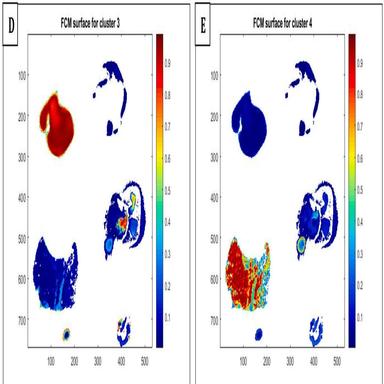
Fuzzy C-Means (FCM) clustering analysis of the NMI region at ambient temperature. Clusters 1 through 4 are visualized in panels A to E, respectively, with the membership probabilities indicated by the color scale. Panel C presents the centroid spectra for each cluster, with lines corresponding to the cluster numbers shown in panels A, B, D, and E.